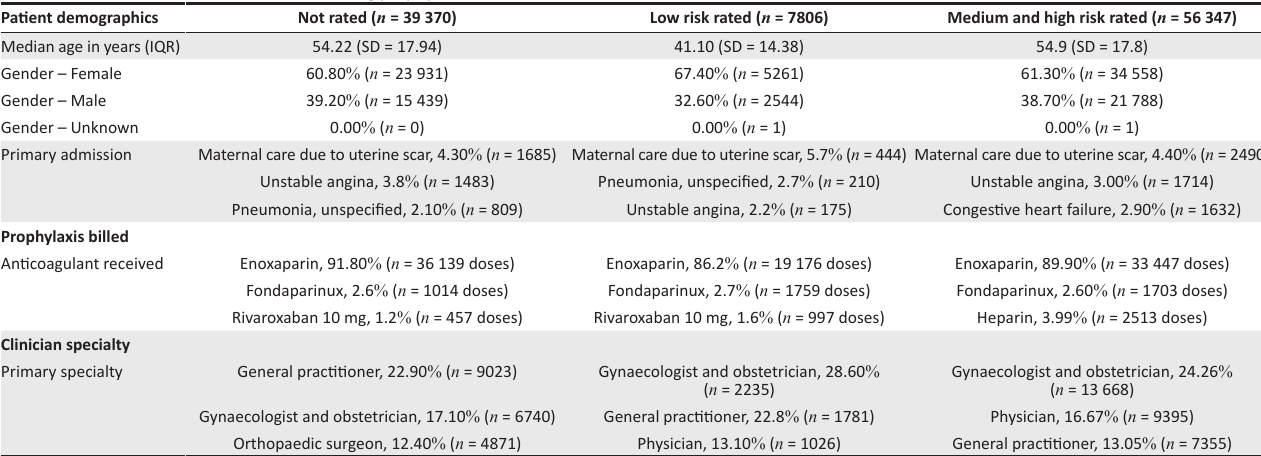
Figure 2: South African Society of Thrombosis and Haemostasis prophylactic practice guidelines for venous thromboembolism. TABLE 2: Patient characteristics in those receiving